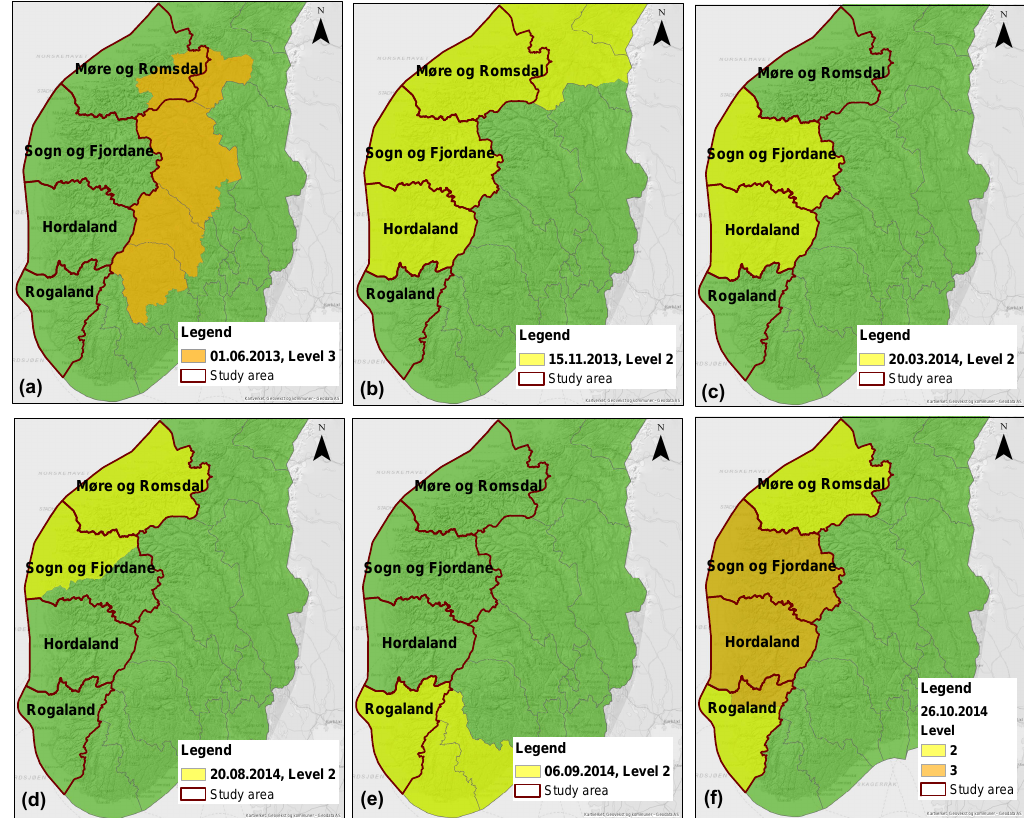
Figure 5. Examples of early warning areas and levels during 2013–2014.